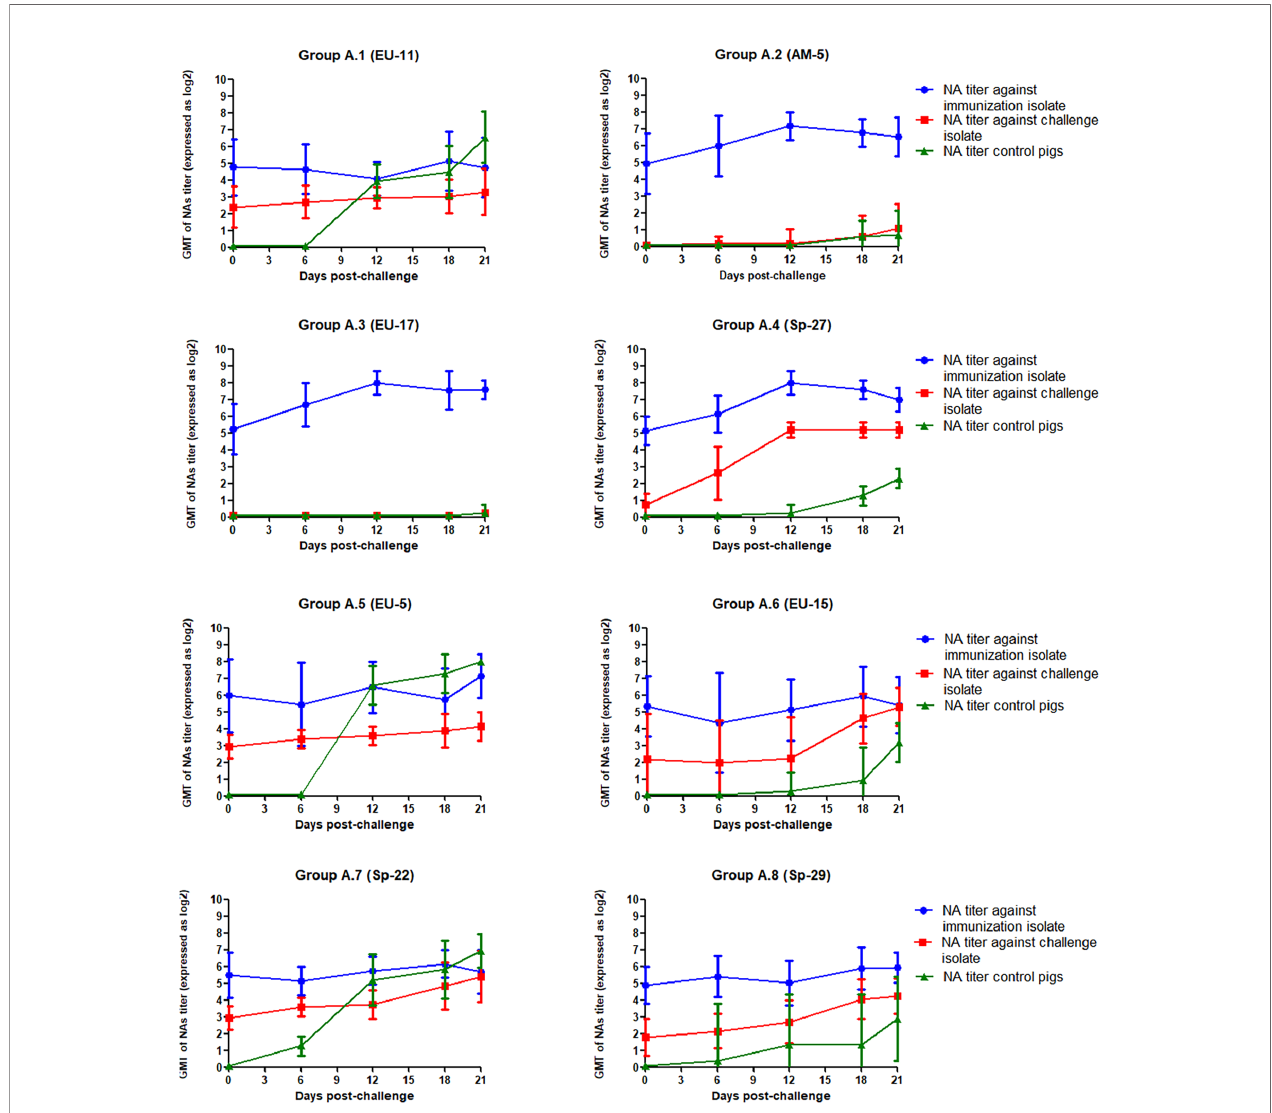
FIGURE 2 | GMT of NAs against the immunization and challenge PRRSV isolates in immunized pigs and against challenge PRRSV isolate in control pigs in the eight groups included in the study from the day of challenge to the end of the experiment in Experiment A. The graph illustrates the GMT ± standard